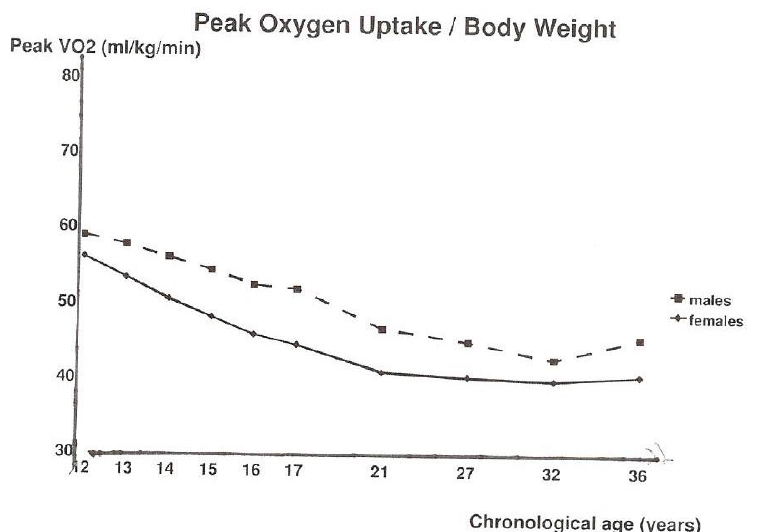
Figure 7. Mean values of peak oxygen uptake relative to bodyweight separately for males and females [14].